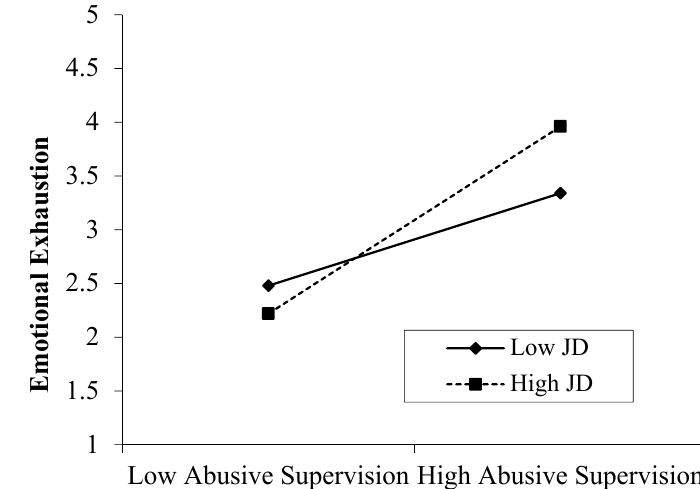
Figure 2. Moderating effect of abusive supervision and job demands (JD) on emotional exhaustion.